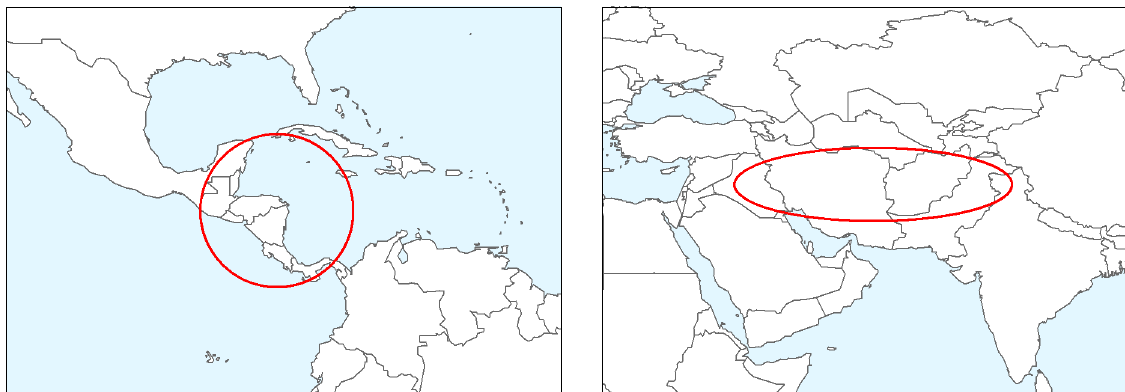
Fig. 3. Examples of the approximate native range of Carica papaya (left) and Punica granatun